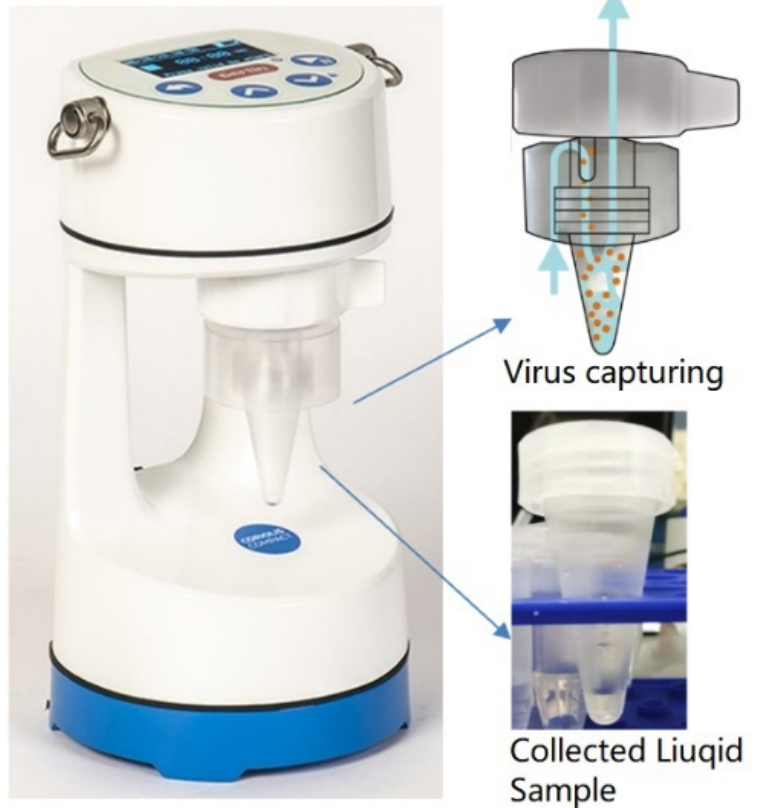
Figure 5. Coriolis Sampler used for capturing SARS-CoV-2 virus. Liquid samples containing SARS-CoV-2 virions were collected and centrifuged in a cone-shaped vial.